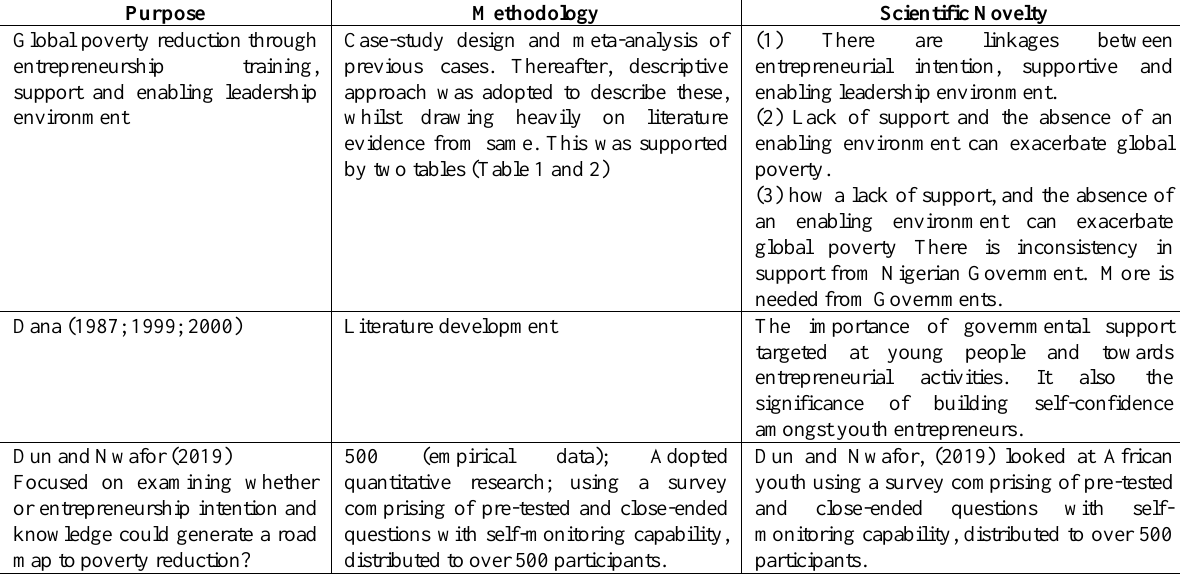
Table 2. Highlighting the Differences Between the Previous Studies and Current